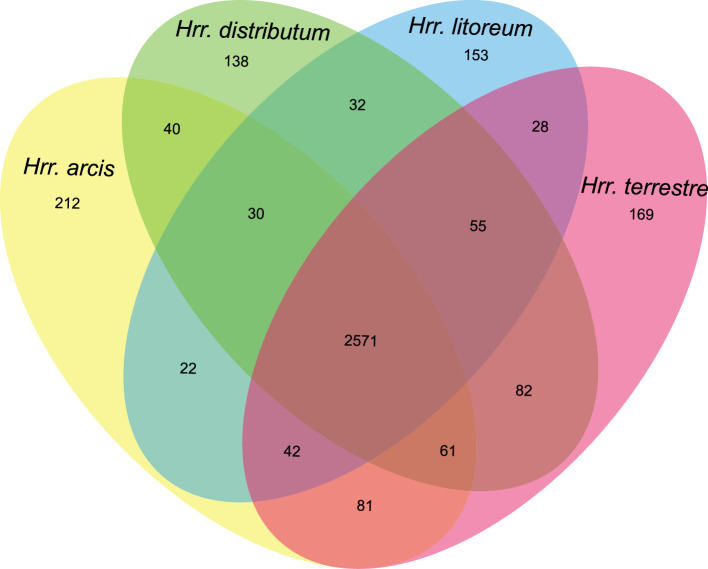
Venn diagram showing the core orthologous and unique proteins for the type strains of
Halorubrum distributum
 JCM 9100T,
Halorubrum terrestre
 JCM 10247T,
Halorubrum arcis
 JCM 13916T and
Halorubrum litoreum
 JCM 13561T.